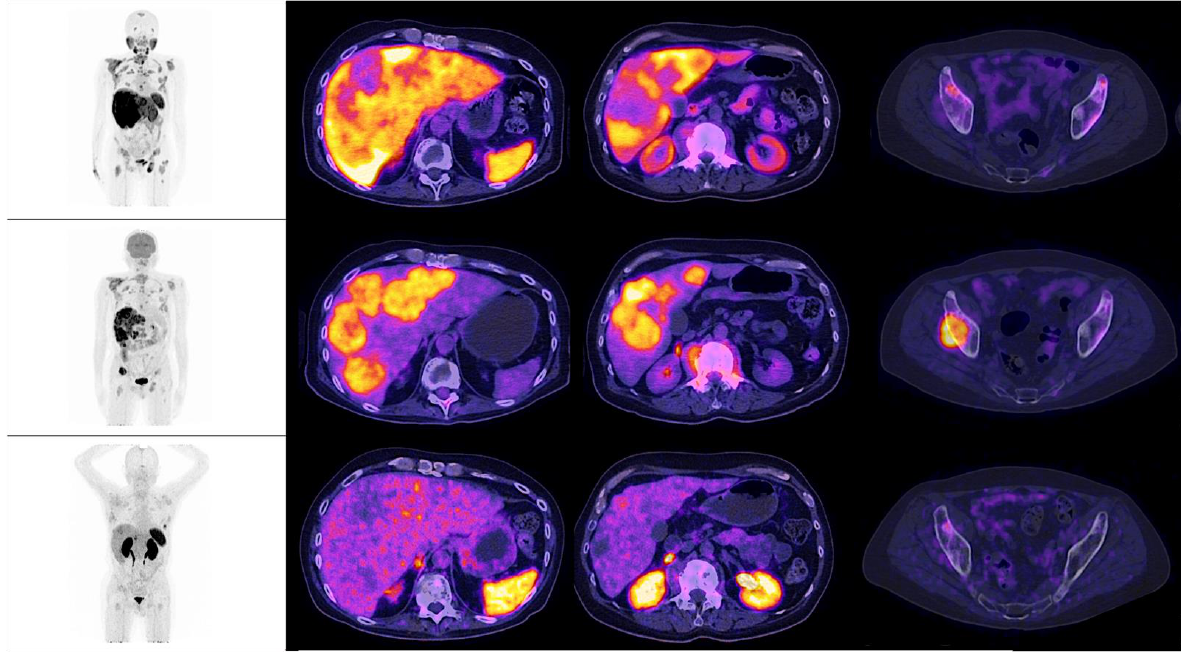
Figure 2. Patient number 4, a 54-year-old male, with an initial histopathological report of prostate adenocarcinoma, and a Gleason score of 9 (4 + 5). He was treated with surgical transurethral